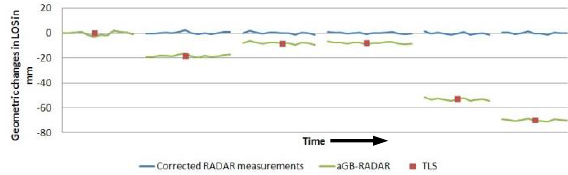
Figure 10: Outcome of aGB-RADAR for an area where large geometric changes occurred Figure 10 depicts the final results: corrected TRS data is represented by blue lines, TLS measurements by red squares and the combined outcome derived by aGB-RADAR are denoted by green